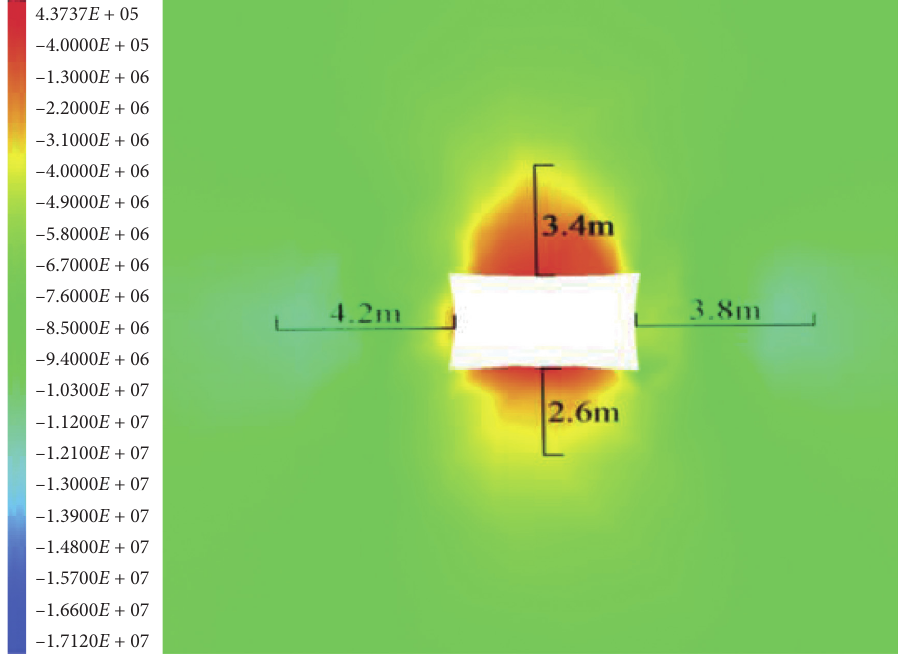
Figure 6: The vertical stress distribution of surrounding rock in the air-return roadway of No. 3318 working